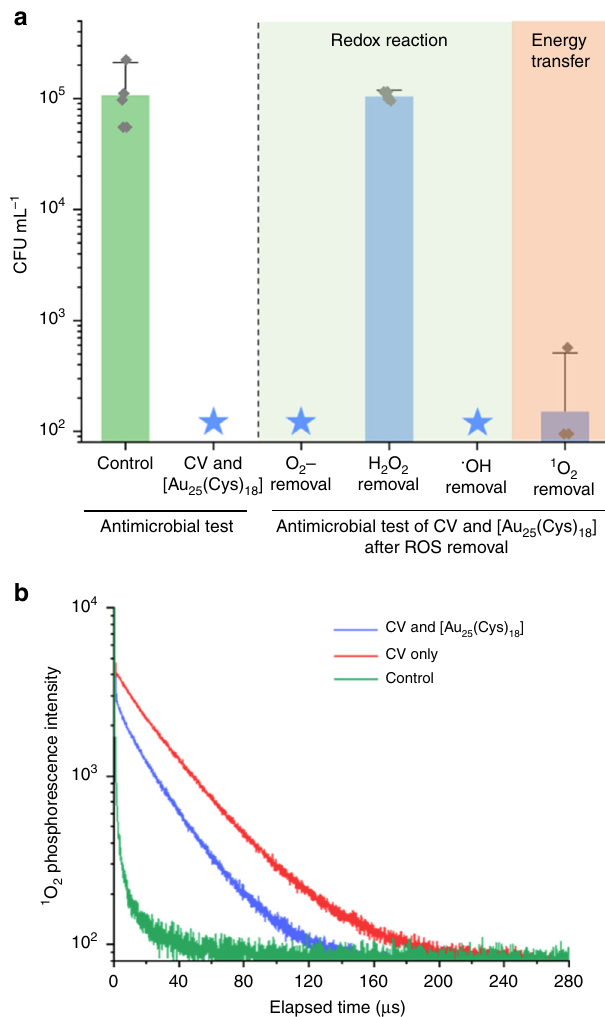
Fig. 4 Characterisation of reactive oxygen species (ROS) induced by CV only and CV&[Au 25 (Cys) 18 ]. a Bactericidal activity of CV&[Au 25 (Cys) 18 ] after removal of reactive oxygen species (ROS) containing superoxide (O 2 - ), hydrogen peroxide (H 2 O 2 ), and singlet oxygen ( 1 O 2 ). CV&[Au 25 (Cys) 18 ] samples were exposed to white light source with an intensity of 312 lux on average for 6 h (n = 6 independent samples). CV indicates crystal violet. b Time-resolved 1 O 2 phosphorescence decay on control, CV only, and [CV&Au 25 (Cys) 18 ] ( λ Ex = 532nm, λ Em = 1270nm). The phosphorescence decay was analysed using PicoQuant Fluo fi t software. Data in ( a ) presented as mean± SD. Blue star represents below detection limit: <10 2 CFU mL − 1